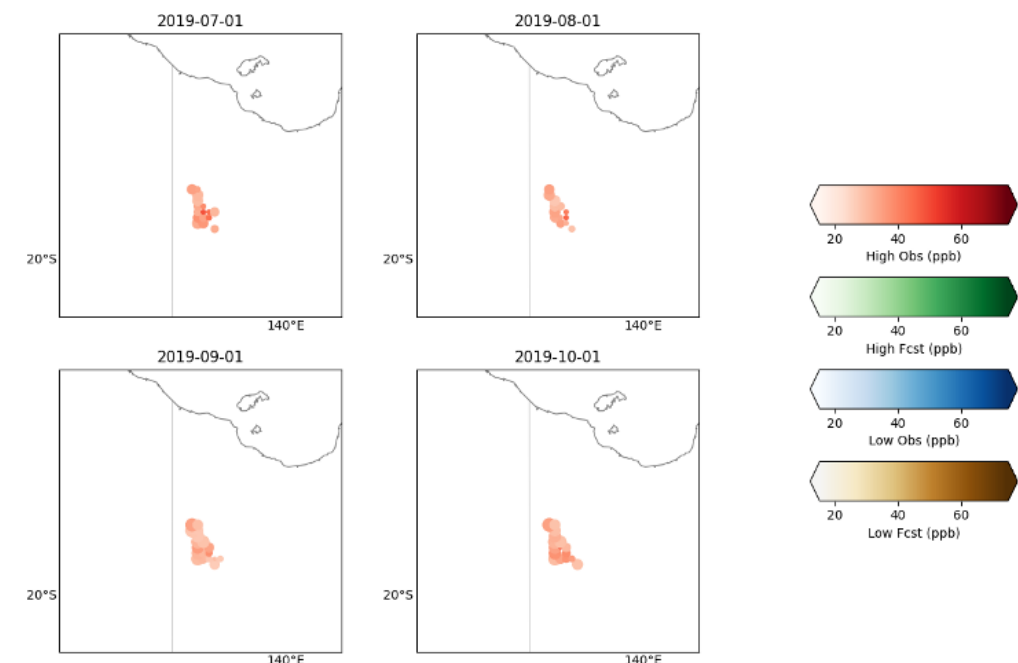
Figure 17. Outlier detection and classification over Australia. Dates indicate the end date of the 30d time window.